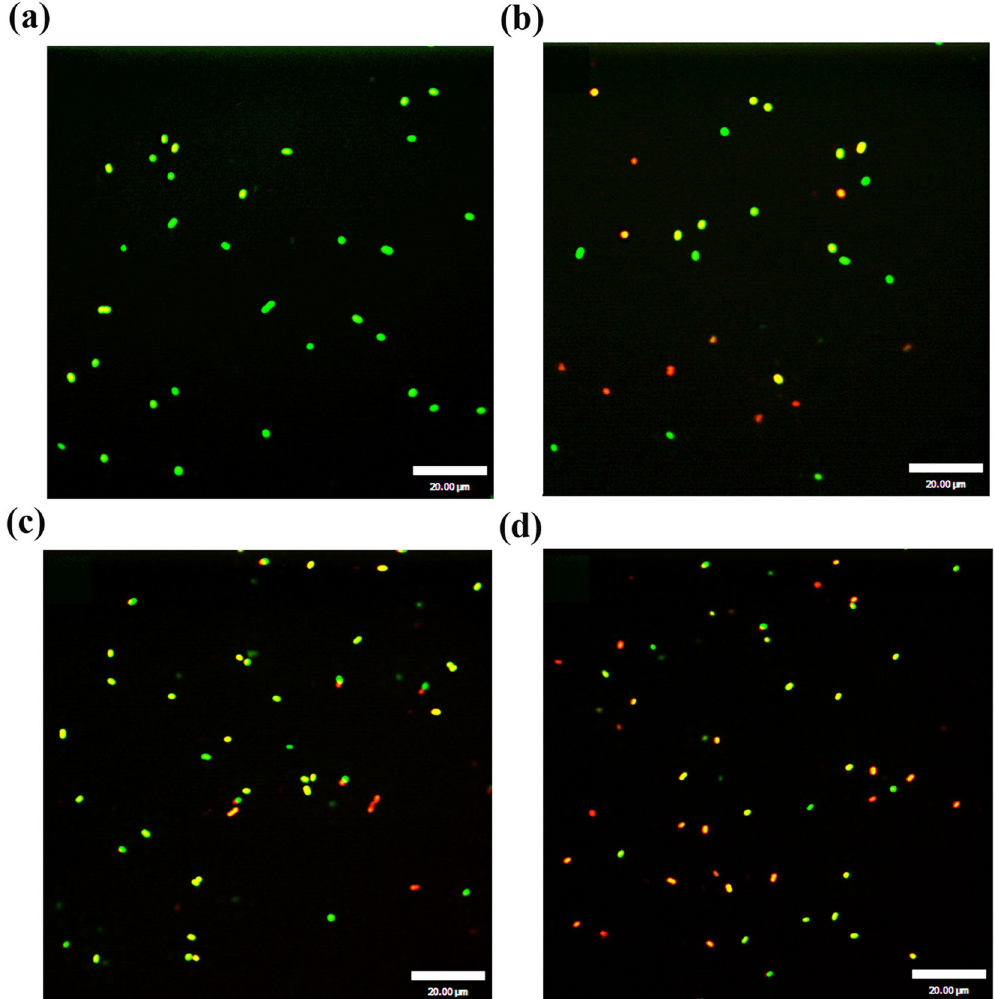
Figure 5. Confocal laser scanning micrographs of untreated S. saprophyticus P2 cells ( a ), and cells treated with nisin ( b ), SlpB ( c ), nisin + SlpB ( d ). Nisin concentration, 100 μ g/mL; the concentration of SlpB concentration, 40 μ